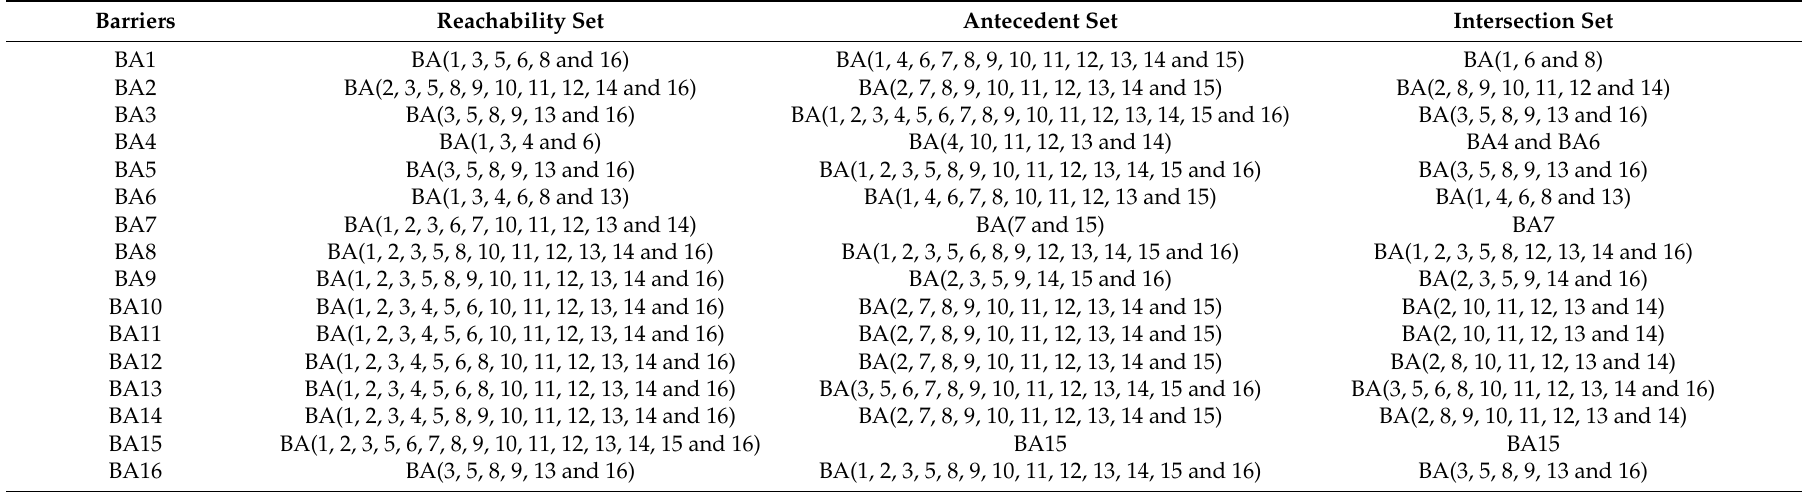
Table 9. Level I partition of the hierarchical structure of the barriers using a final reachability matrix.